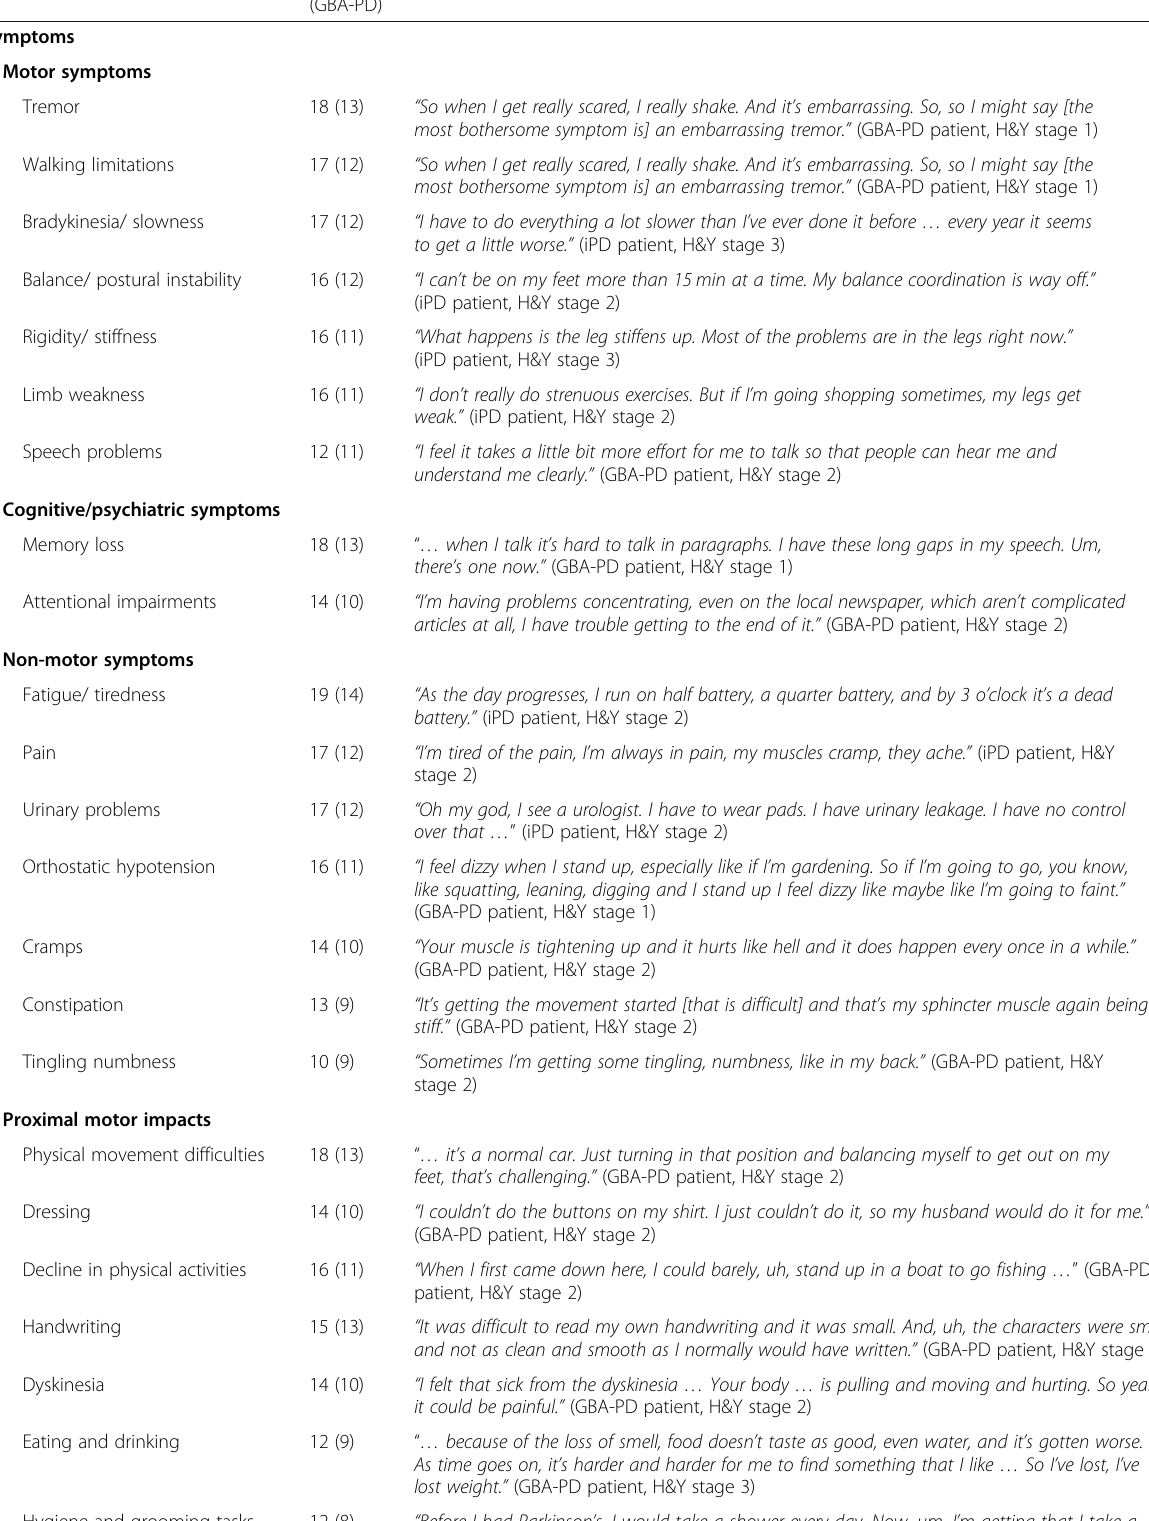
Table 3 Patient-reported ‘ most bothersome symptoms ’ and ‘ symptoms most important to treat ’